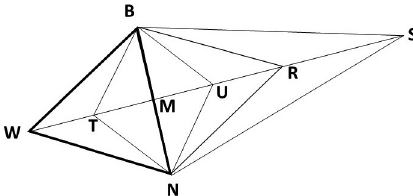
Figure 2 - Possible movements for the modi fi ed